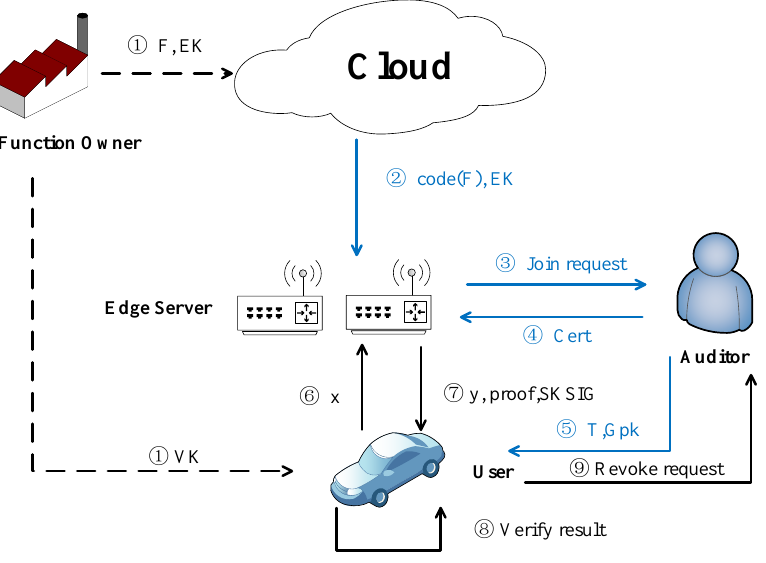
Figure 2. Model Architecture (Dotted lines stand for the initialize phase. Blue lines and black solid lines denote the join phase and outsource computing